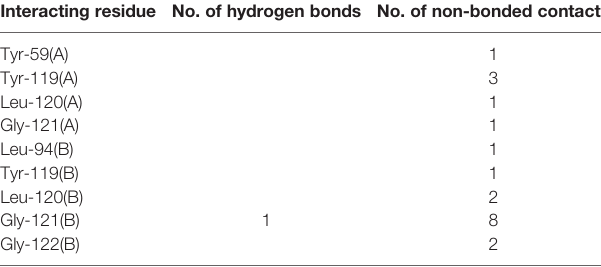
FIGURE 5 | Molecular docking of andrographolide with human TNF homodimer. (A) The pose of andrographolide within the binding site of TNF homodimer. The NFkB1 is shown in cartoon representation colored green (Chain A) and cyan (Chain B) with the binding site in surface representation. The andrographolide and the native inhibitor are shown as sticks colored blue and yellow, respectively, with red oxygen and blue nitrogen atoms. (B, C) Protein-ligand interaction plots of andrographolide and the native inhibitor JNJ525 with TNF homodimer. The andrographolide and hydrogen bonding residue are shown in ball and sticks representation, with balls representing atoms and sticks representing the bond between two atoms. The color of balls distinguishes among atom types as C-atom in black, O-atoms in red, and N-atoms in blue colors. The non-bonded interactions labeled with interacting residue are shown as red arcs with bristles, while the hydrogen bond is shown as a green line labeled with bond length in Å. The residues common among interacting residues of both the native inhibitor and the andrographolide are TABLE 5 | The residues of TNF homodimer interacting with andrographolide.